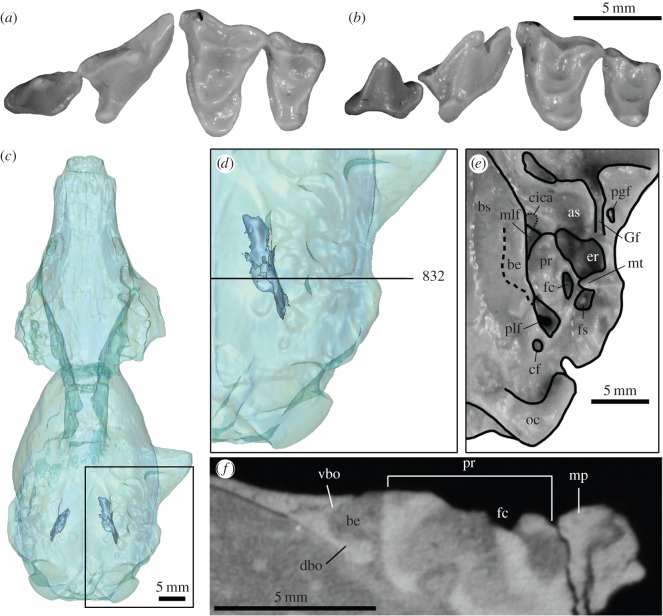
Craniodental morphology of Gustafsonia cognita, gen. et comb. nov. (a) left P3-M2 of cast of holotype TMM 40209-200 in occlusal view; (b) same in oblique lingual view; (c) digital three-dimensional reconstruction (see text) of holotype cranium in ventral view, showing locations of basicranial embayment (blue) for inferior petrosal sinuses; (d) left basicranial morphology, magnified from boxed area in (c) and indicating position of coronal section no. 832 figured in (f); (e) external ventral view of left basicranial region (cast of holotype; basioccipital embayment is invisible, and its approximate medial extent is marked by dashed line); (f) coronal section no. 832 from Digital Morphology Library (see text) showing cross-section through the left auditory region of holotype (ventral to top; lateral to right). Panels (c,d,f) produced with permission from the University of Texas HRXCT Facility. Abbreviations: as, alisphenoid; be, basioccipital embayment for inferior petrosal sinus; bs, basisphenoid; cf, condyloid foramen; cica, canal (dotted line) for anterior loop of internal carotid artery; dbo, dorsal lip of basioccipital; er, epitympanic recess; fc, fenestra cochlea; fs, fossa for stapedius muscle; Gf, Glaserian fissure; mlf, middle lacerate foramen; mp, mastoid process; mt, mastoid tubercle; oc, occipital condyle; pgf, postglenoid fossa; plf, posterior lacerate foramen; pr, petrosal promontorium; vbo, ventral floor of basioccipital.